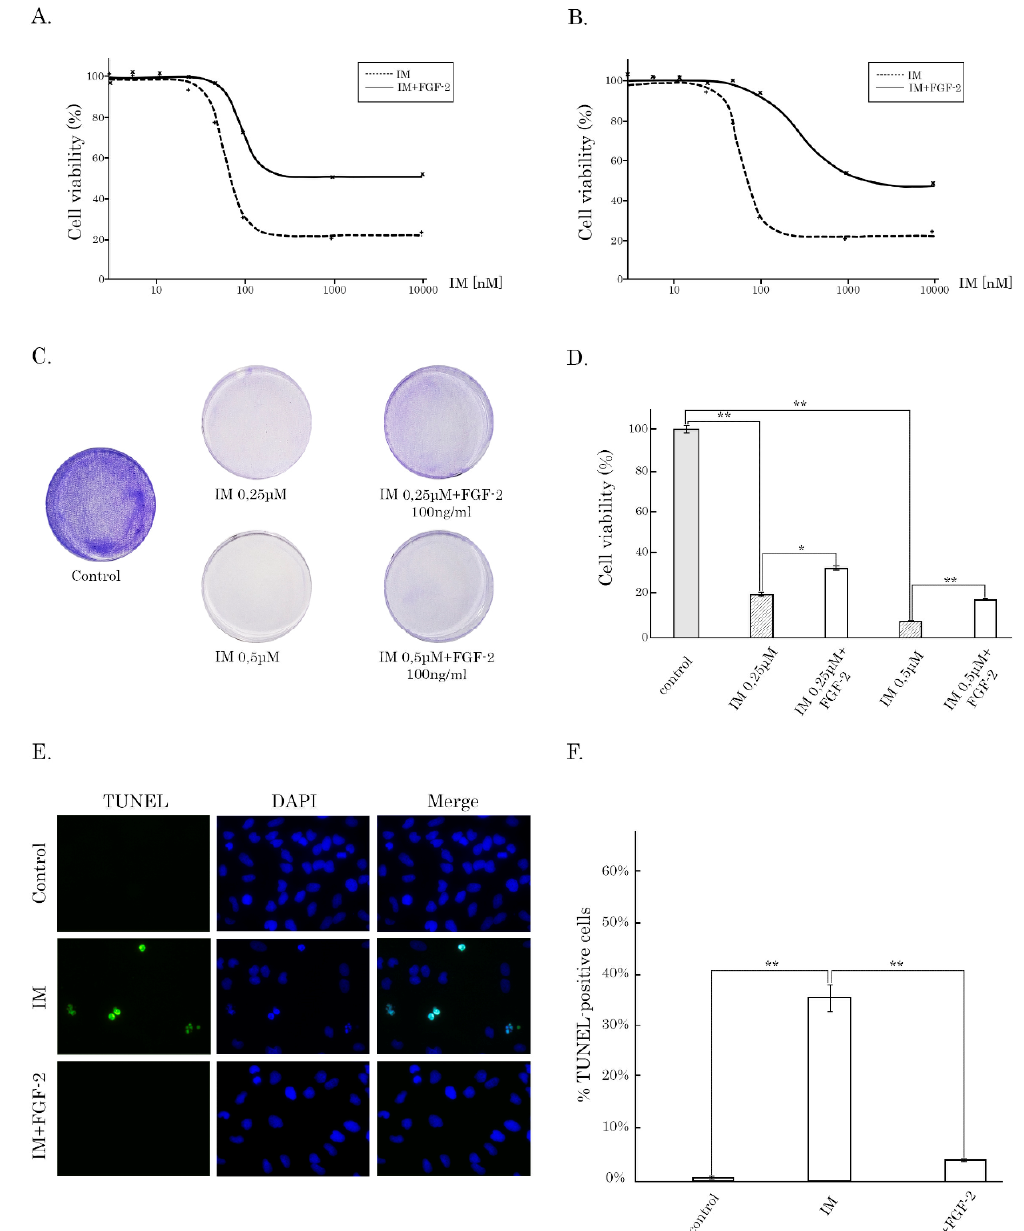
Figure 5. Activation of FGF ‐ signaling rescues IM ‐ naïve GISTs from KIT inhibition. ( A ) MTS ‐ based cellular viability assay in GIST T ‐ 1 cells treated with IM alone for 48 h or in presence with FGF ‐ 2 (100 ng/mL). ( B ) MTS ‐ based viability assay in GIST T ‐ 1 cells non ‐ treated or pretreated with FGF ‐ 2 (100 ng/mL) for 14 days and further treated with IM for 48 h. ( C ) Crystal violet staining of GIST T ‐ 1 cells that were treated with IM alone or IM in the presence of FGF ‐ 2 for 72 h. The cells treated with DMSO were used as a control. The culture dishes were fixed with ice ‐ cold 100% methanol, stained with crystal violet, and photographed. ( D ) Quantification of crystal violet staining of GIST T ‐ 1 cells, as shown in Figure 5C. ( E ) TUNEL ‐ staining (40×) of GIST T ‐ 1 cells either mock ‐ treated with DMSO or treated with IM (1 μ mol/L) alone or in the presence of FGF ‐ 2 (100 ng/mL) for 72 h. DAPI was used to stain the nuclei. ( F ) Quantification of the percentage of TUNEL ‐ positive GIST T ‐ 1 cells treated with DMSO (control), IM alone, or in the presence of FGF ‐ 2, as shown above. Columns, mean of at least 3 independent experiments with at least 100 cells calculated per experiment; bars, standard error (SD). Significant differences with p < 0.05 (*), p < 0.01 (**) from n ≥ 3 using unpaired Student’s t ‐ test.